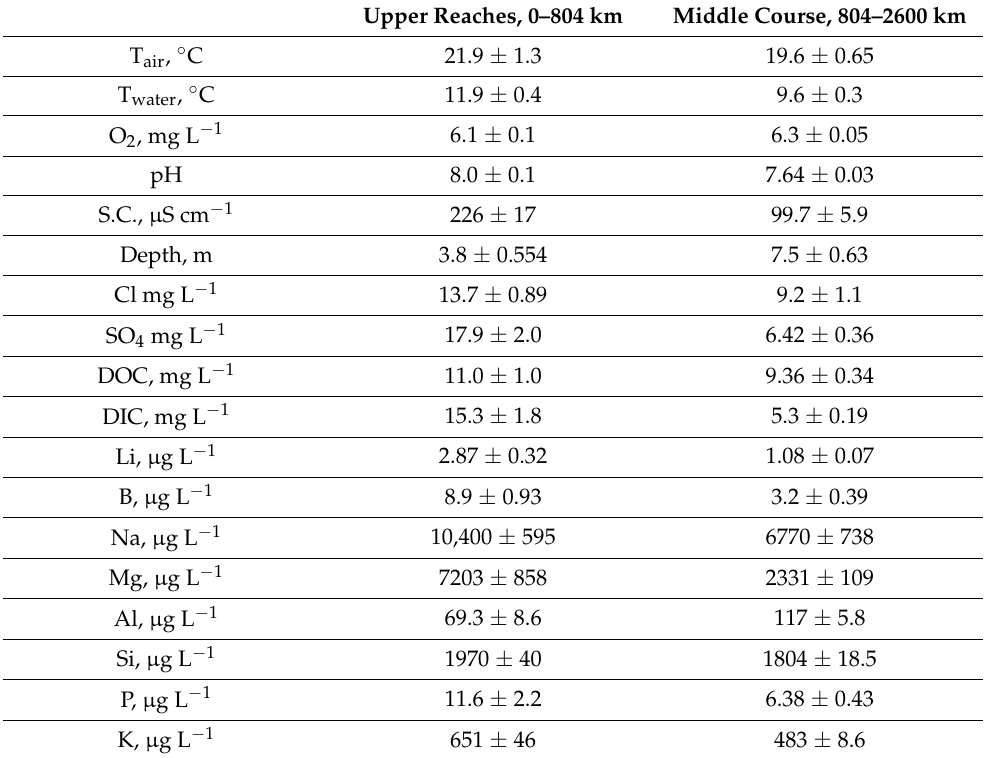
Table 1. Major and trace element concentration (average ± s.d.) in the Lena River main stem. The distances are along the river, starting from Zhigalovo (the Lena River